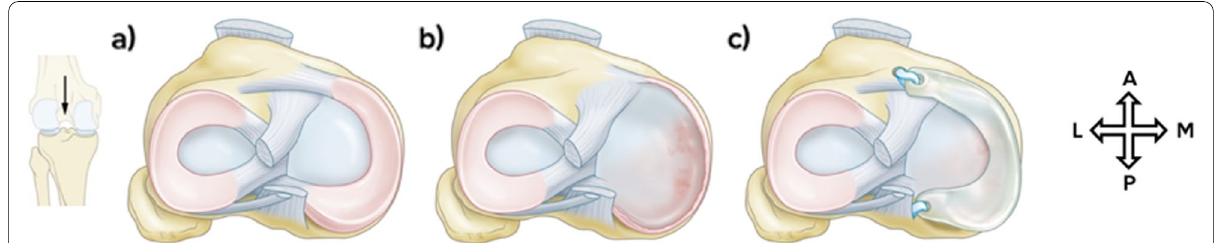
Fig. 4 Schematic representation of the different situations tested in the cadaveric knee joints. a Native menisci. b Total medial meniscectomy. c Second-generation medial meniscus prosthesis. The arrows indicate the anterior (A), posterior (P), lateral (L) and medial (M) sides of the tibial